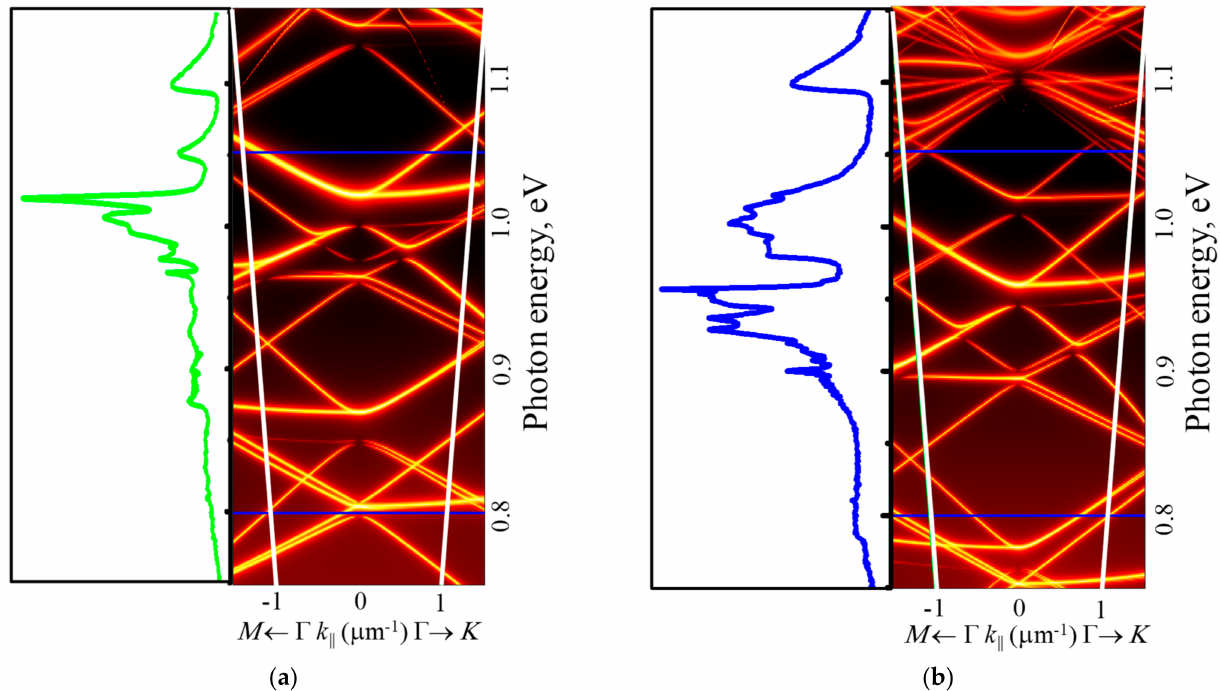
Figure 8. The emissivity near the Г -point simulated for the structured sample with the periods of PhC lattice a = 0.7 µ m ( a ) and 0.8 µ m ( b ) and the experimental micro-PL spectra from corresponding areas. For these periods and the pits radii r ~ 55 nm, the parameter r/a is equal to ~0.08 and 0.07 for figures ( a ) and ( b ), respectively. The emissivity is represented in the logarithmic color scale. White lines in the figures denote the 15 ◦ light cone from which the PL signal is collected. Horizontal blue lines bound the spectral range of intrinsic photoluminescence of Ge(Si) QDs and wetting